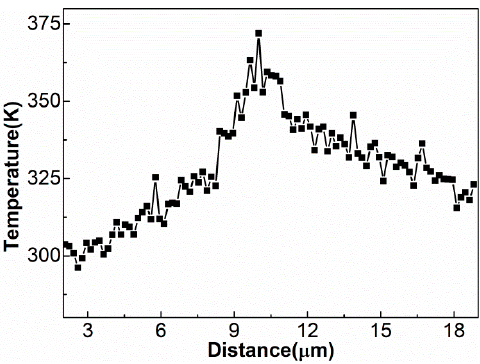
Figure 9. Temperature profile along the transverse cross-section calculated at 5 ns.